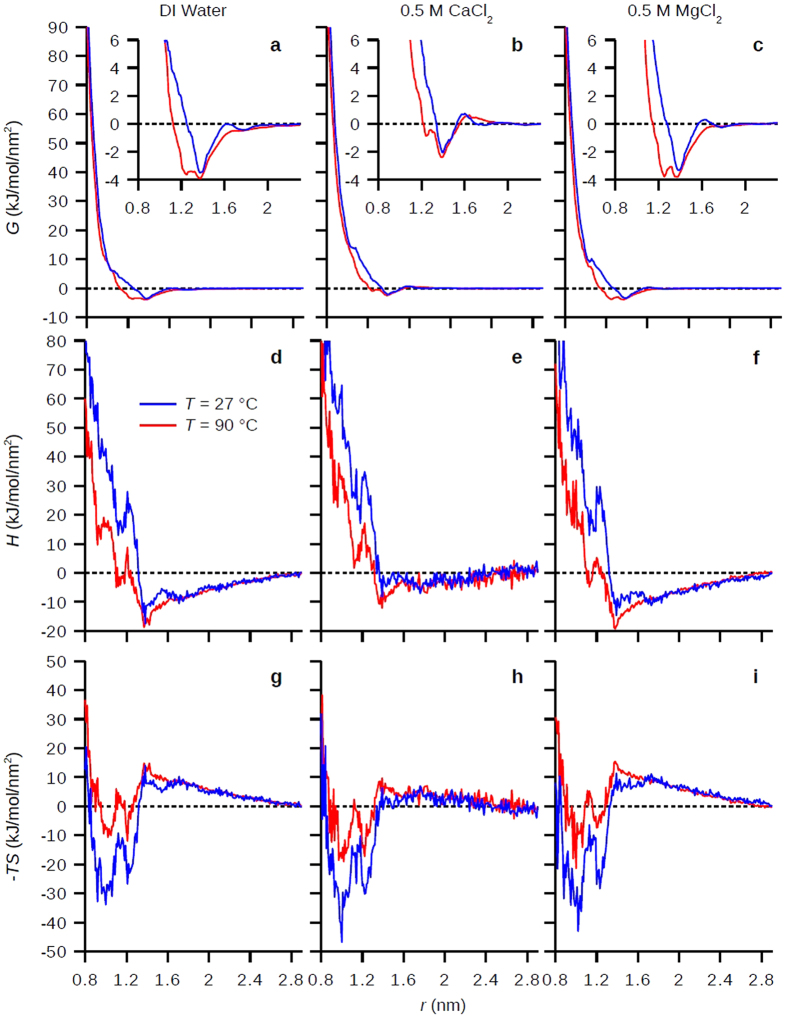
Free energies and enthalpy-entropy contributions for hydration repulsion at different temperatures in different solutions.(a–c) Free energies, G, (d–f) enthalpic contributions, H, and (g–i) entropic contributions, -TS, for the hydration repulsion between carbohydrate surfaces in DI water (a,d,g), 0.5 M CaCl2 (b,e,h), and 0.5 M MgCl2 (c,f,i) at T = 27 or 90 °C.